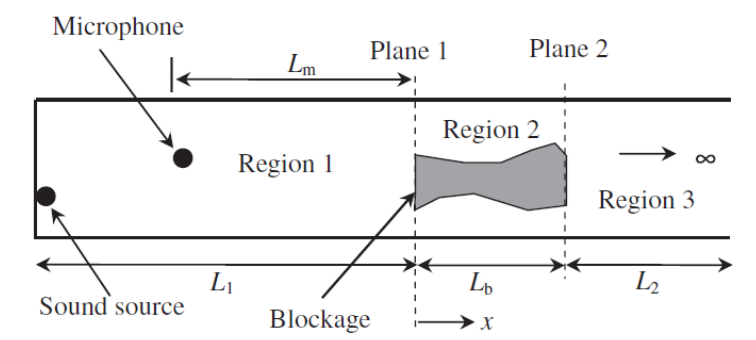
Figure 1. The placement of sound source and microphone in a pipeline for reflectometry test. Reprinted from Applied Acoustics, Volume 87, Duan, W.; Kirby, R.; Prisutova, J.; Horoshenkov, K.V. On the Use of Power Reflection Ratio and Phase Change to Determine the Geometry of a Blockage